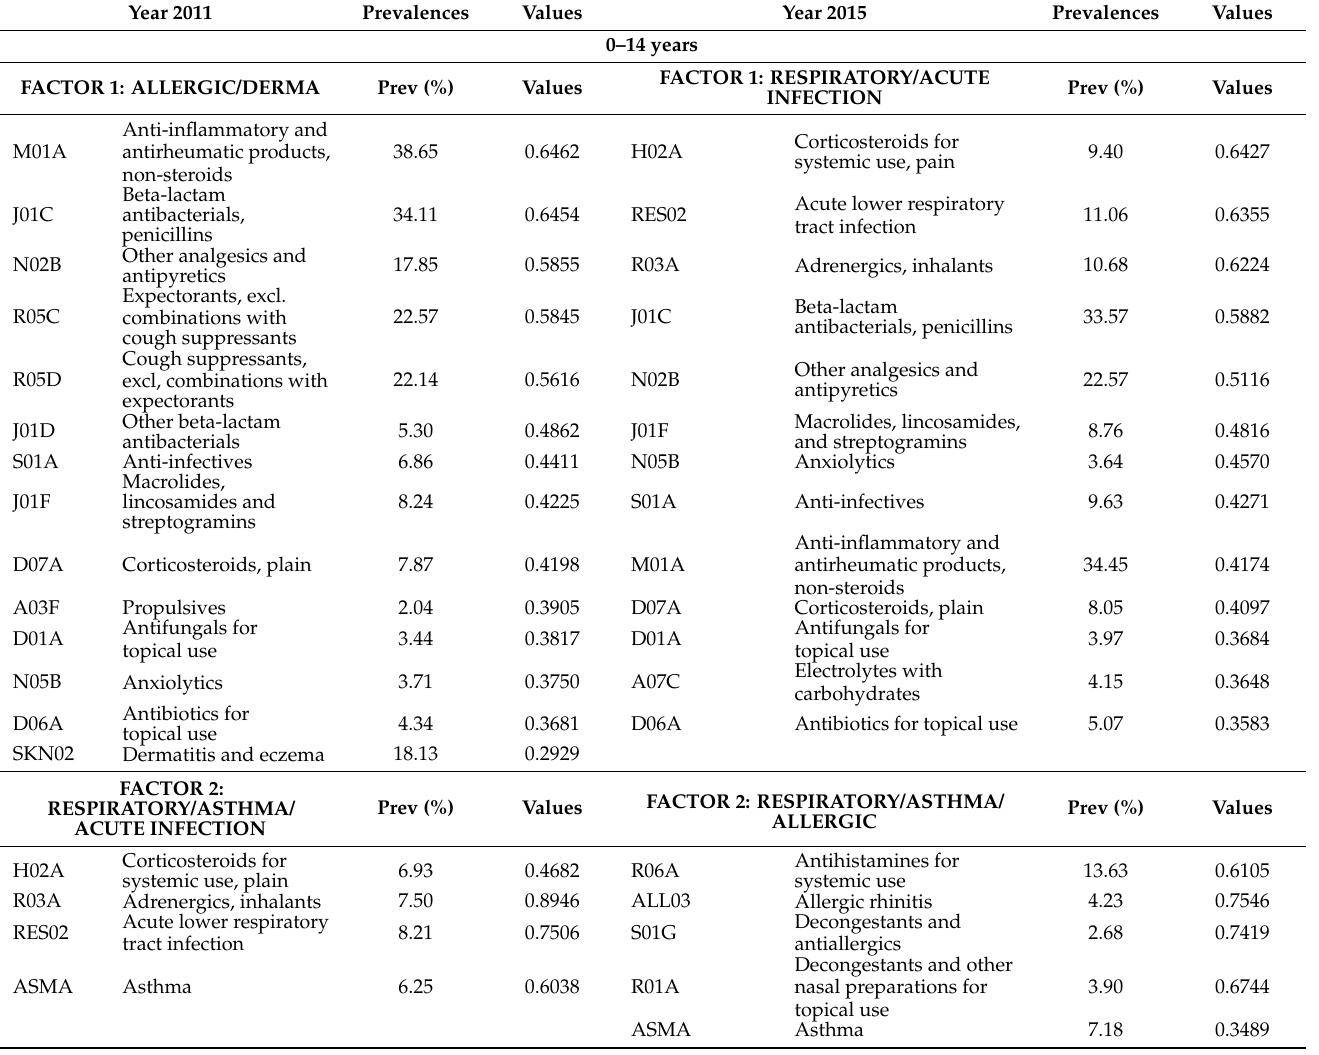
Table 4. Patterns of chronic diseases (EDC codes) and drugs (ATC codes) and factor loading scores in women. Diseases are highlighted in